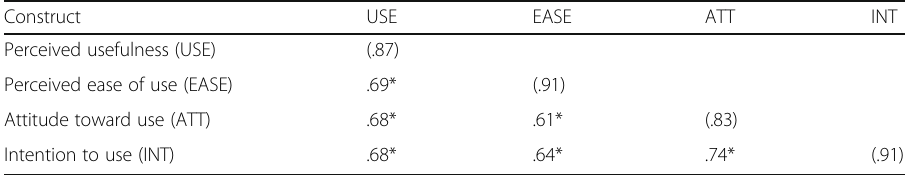
Table 3 Discriminant validity for the measurement